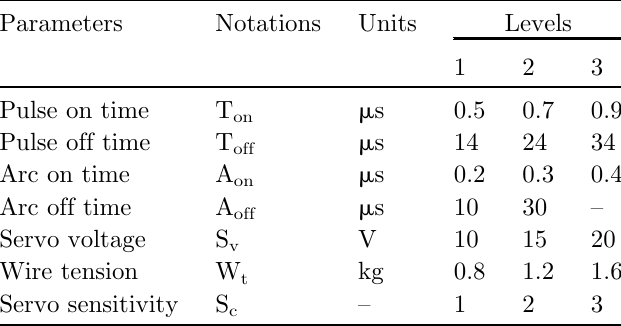
Table 1. Input factors and their